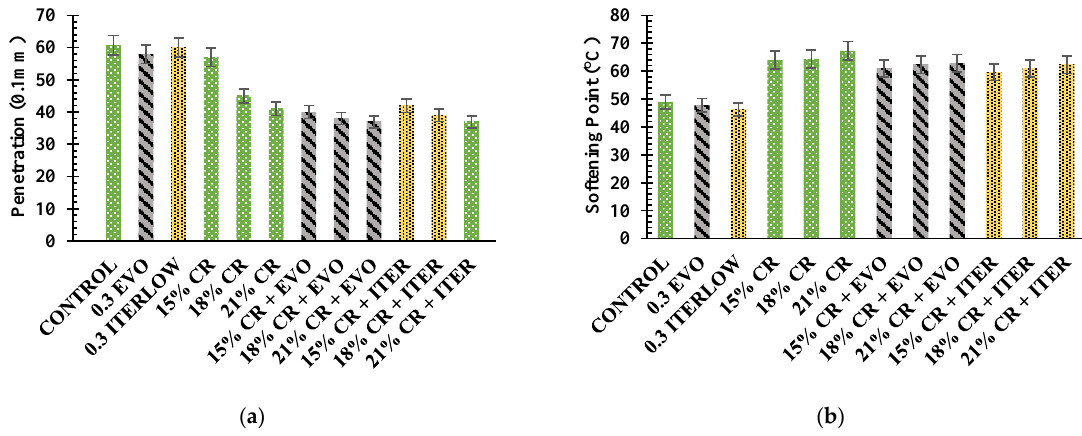
Figure 6. Results of conventional test: ( a ) penetration; ( b ) softening point.